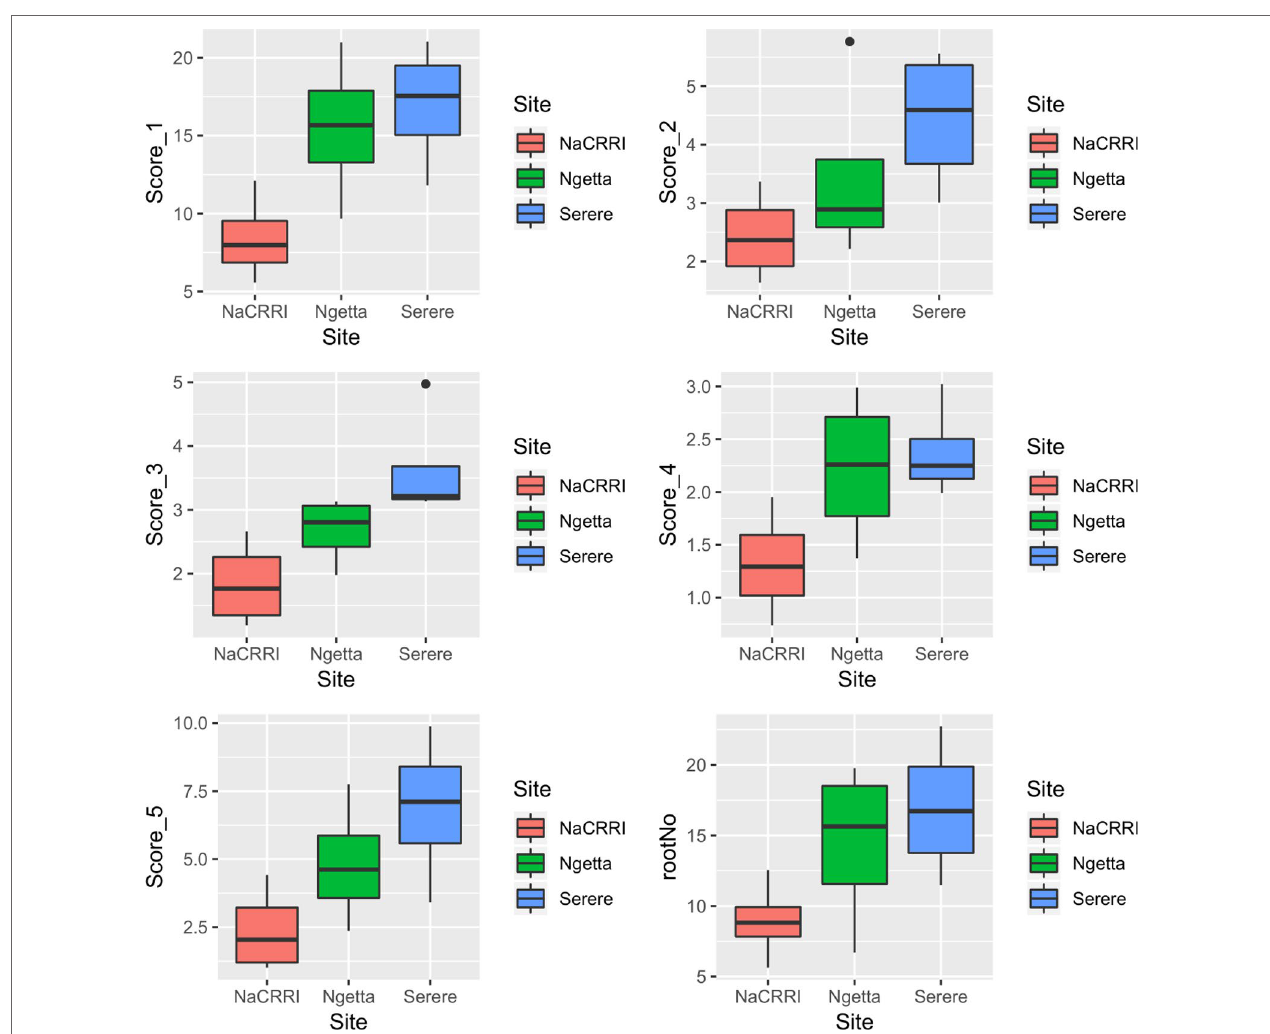
FiGURe 1 | Standard errors associated with CBSD root necrosis severity scores across three sites: Namulonge (central Uganda), Ngetta (northern Uganda) and Serere (eastern Uganda). Score 1 = no necrosis; Score 2 = ≤ 5% necrotic; Score 3 = 6–10% necrotic; Score 4 = 11–25% necrotic and mild root constriction; and Score 5 = 25% necrotic and severe root constriction. RootNo = refers to number of roots sampled per plot.